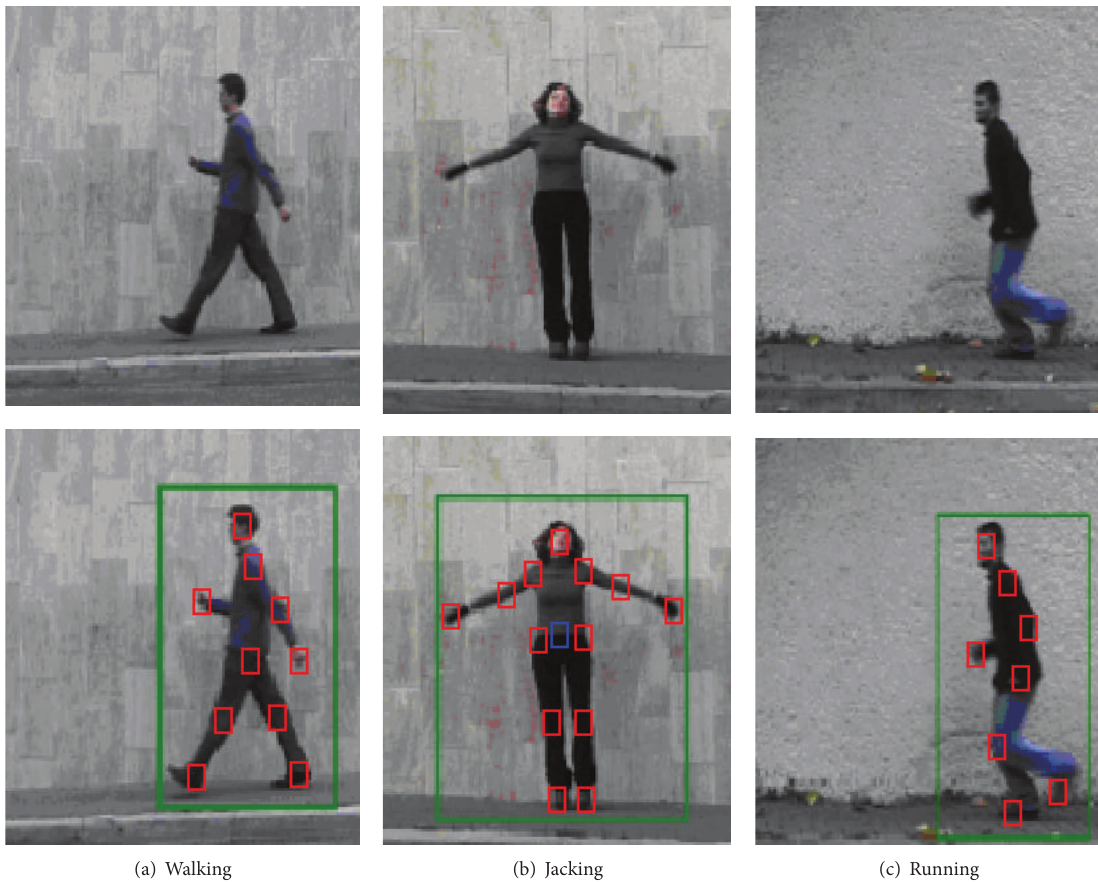
Figure 2: The target tracking results. The original photo stems from Weizmann datasets